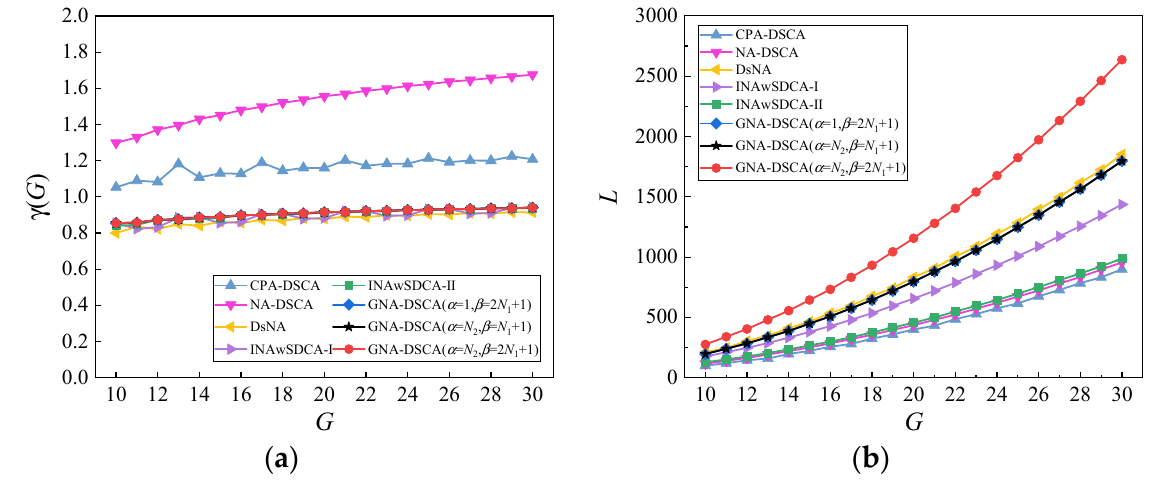
( ) Figure 3. Comparison of virtual array properties. ( a ) DOF ratio γ ( G ) versus the number of sensors γ G versus the number of sensors Figure 3. Comparison of virtual array properties. ( a ) DOF ratio G ; ( b ) Virtual aperture L versus the number of sensors G . G ; ( b ) Virtual aperture L versus the number of sensors G .